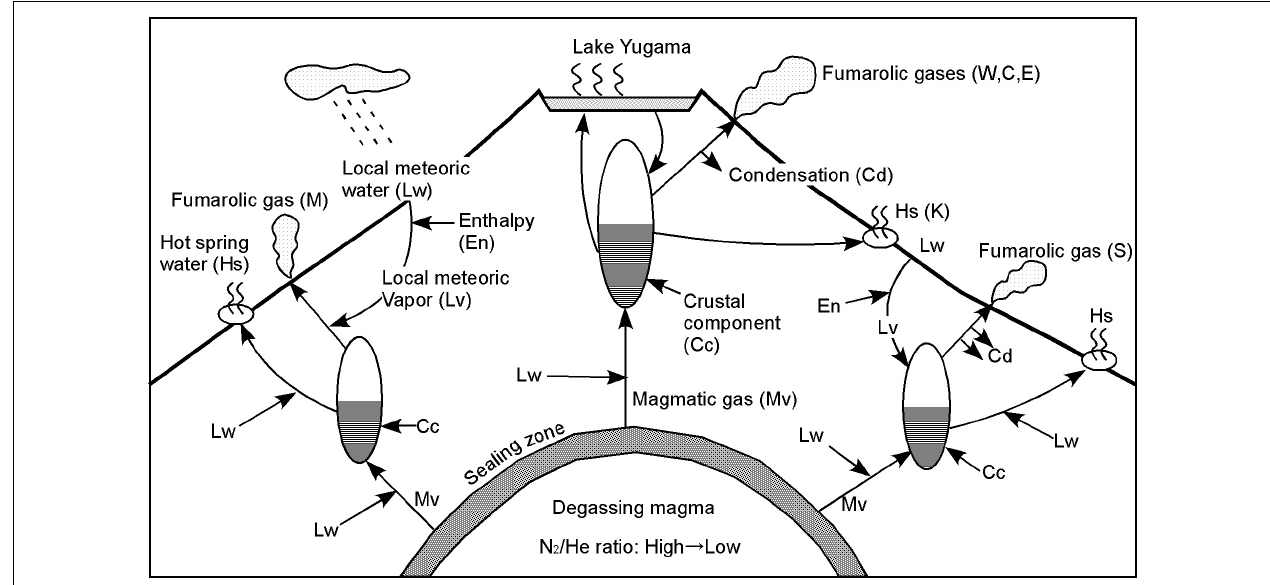
FIGURE 13 | Conceptual model for the magma hydrothermal system at Kusatsu-Shirane volcano.